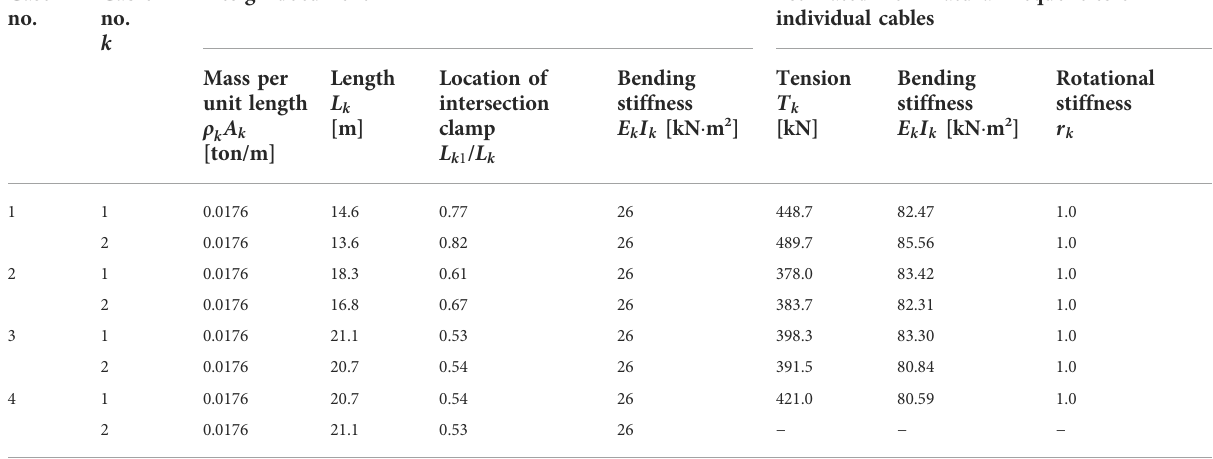
TABLE 4 Speci fi cations of cables considered in fi eld experiment. Case